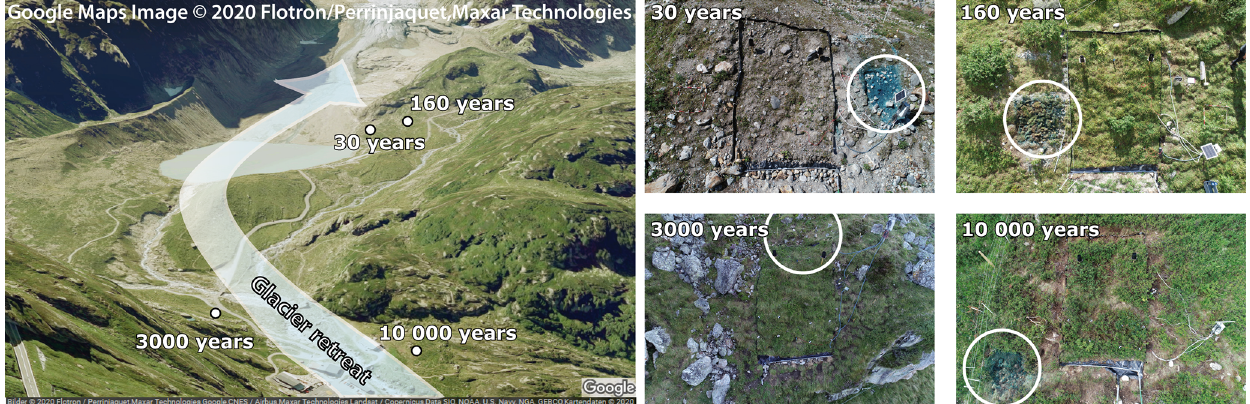
Figure 1. Location (left) and surface cover (right) of the four selected proglacial moraines of the Stein glacier. White circles show locations of one of the three Brilliant Blue experiment plots per age class. Photo of the location is provided by © Google (2020). Photos of the 30-, 160-, and 10000-year-old moraines were taken after the Brilliant Blue experiment (photos taken by Florian Lustenberger).